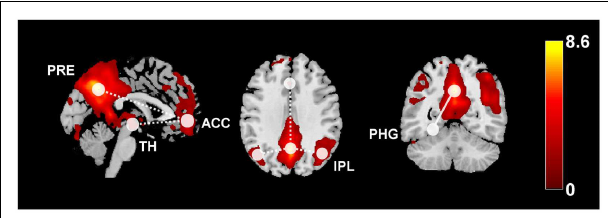
FIGURE 4 |This diagram summarizes the functional connectivity (FC) changes in patients with idiopathic generalized epilepsy compared to healthy controls .The color map shows the default-mode network (z-scores) derived from independent component analysis or RS-fMRI data overlaid on a standard single-subject anatomy (Montreal Neurological Institute space).Widespread FC reductions were found within the DMN (dashed lines), as well as between anterior DMN and the thalamus. Increased FC related to increased disease duration has been observed between posterior DMN regions and the parahippocampal gyrus (solid line). ACC, anterior cingulate cortex, IPL, inferior parietal lobule, PRE, precuneus, PHG, parahippocampal gyrus,TH,